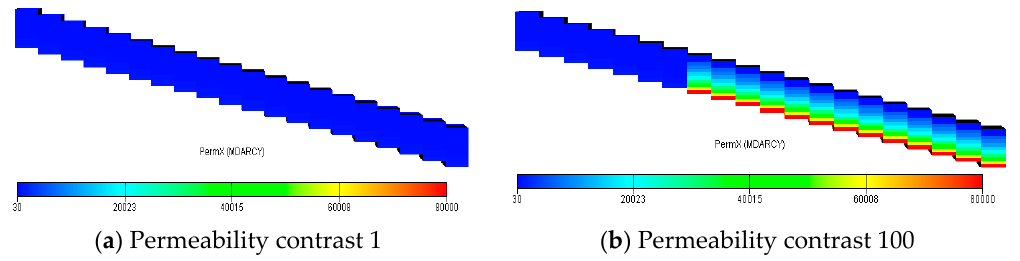
Figure 11. Permeability field profile.